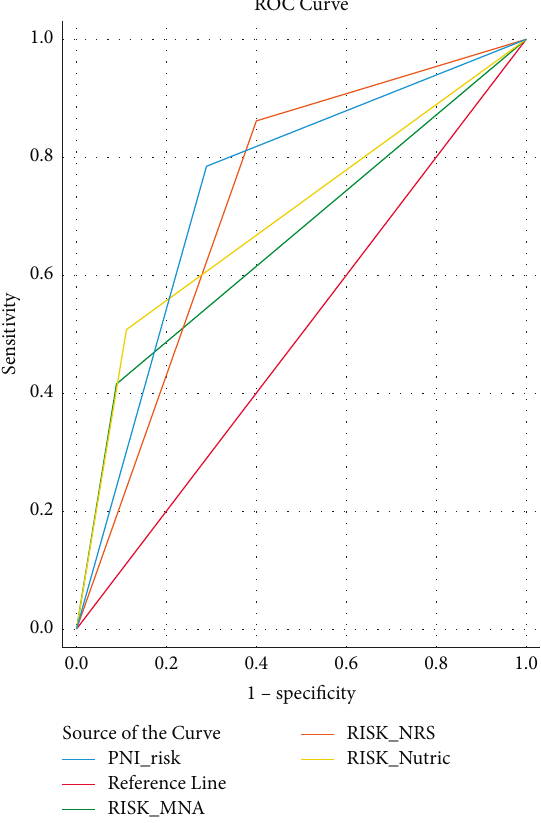
Figure 3: ROC curve for